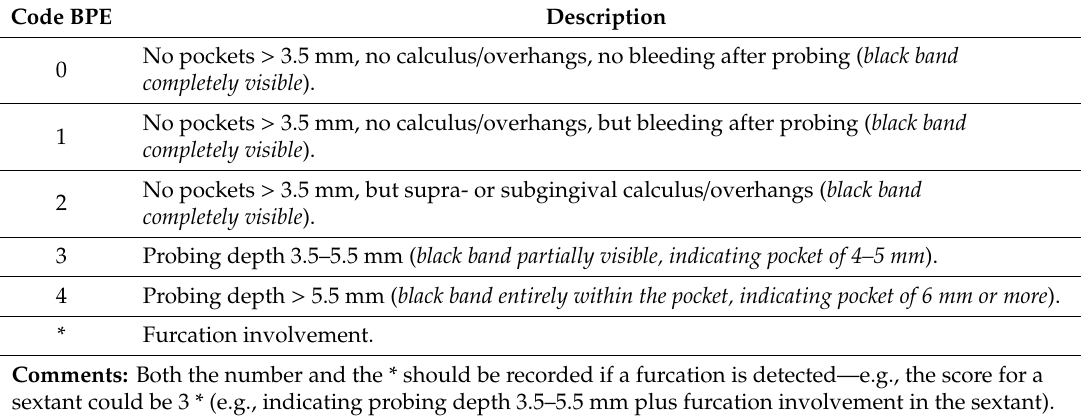
Table 5. Method of determining the scoring codes value when evaluating Basic Periodontal Examination (BPE)